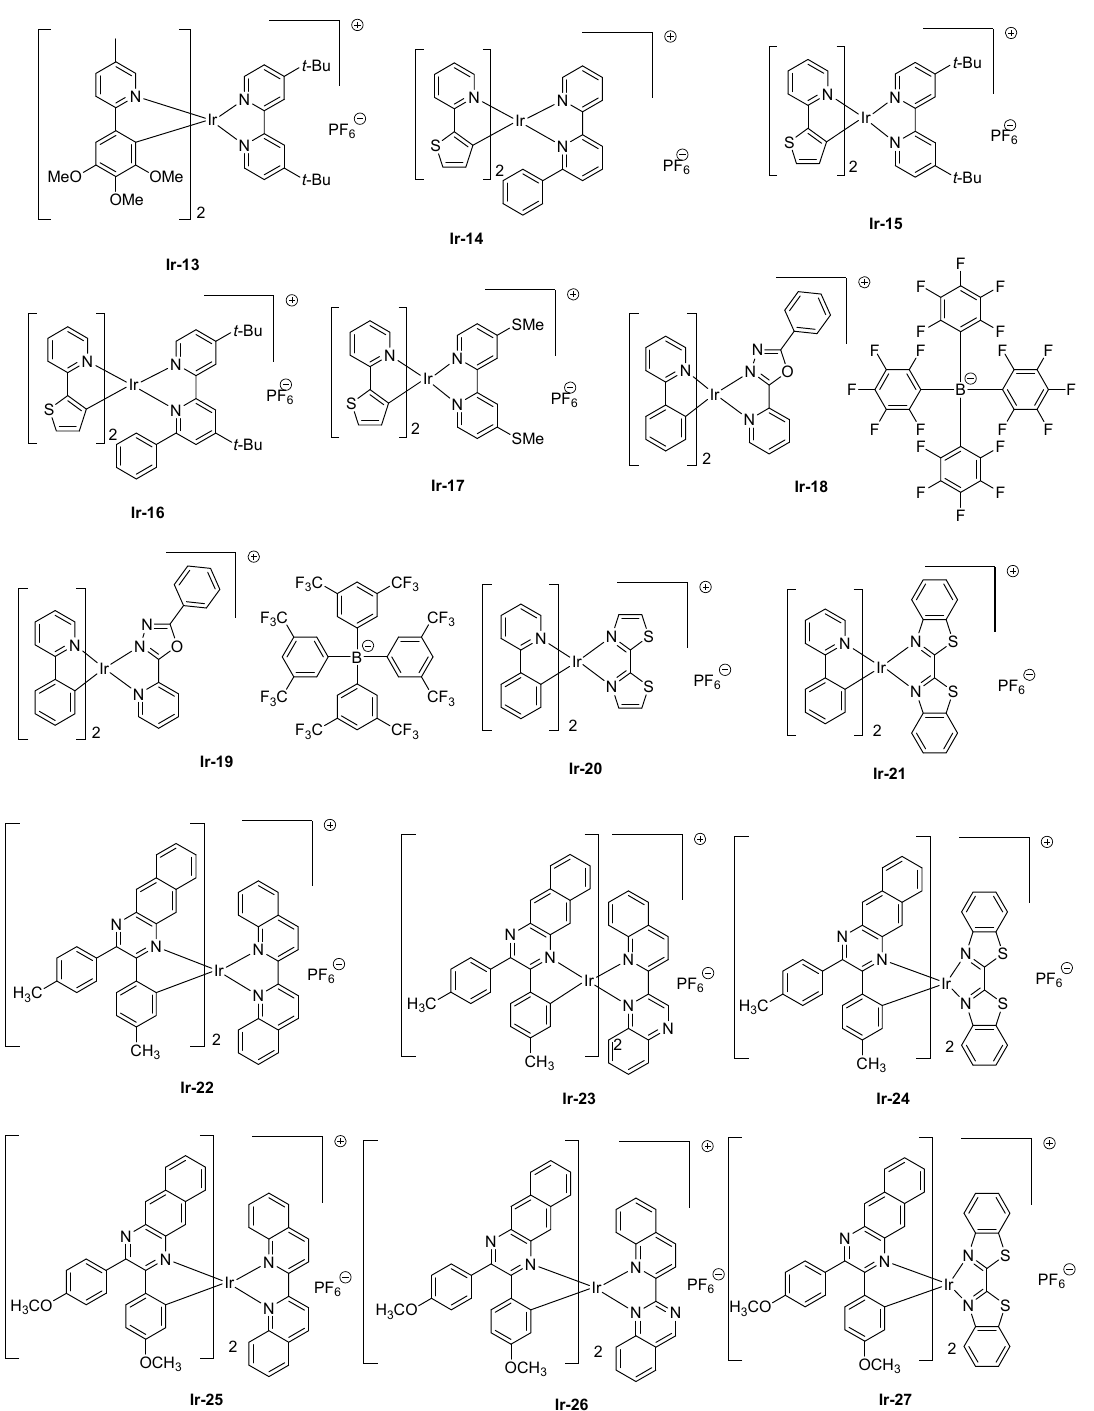
Figure 4. Ir-based near-infrared (NIR) emitters for light-emitting diodes and light-emitting electrochemical cells.